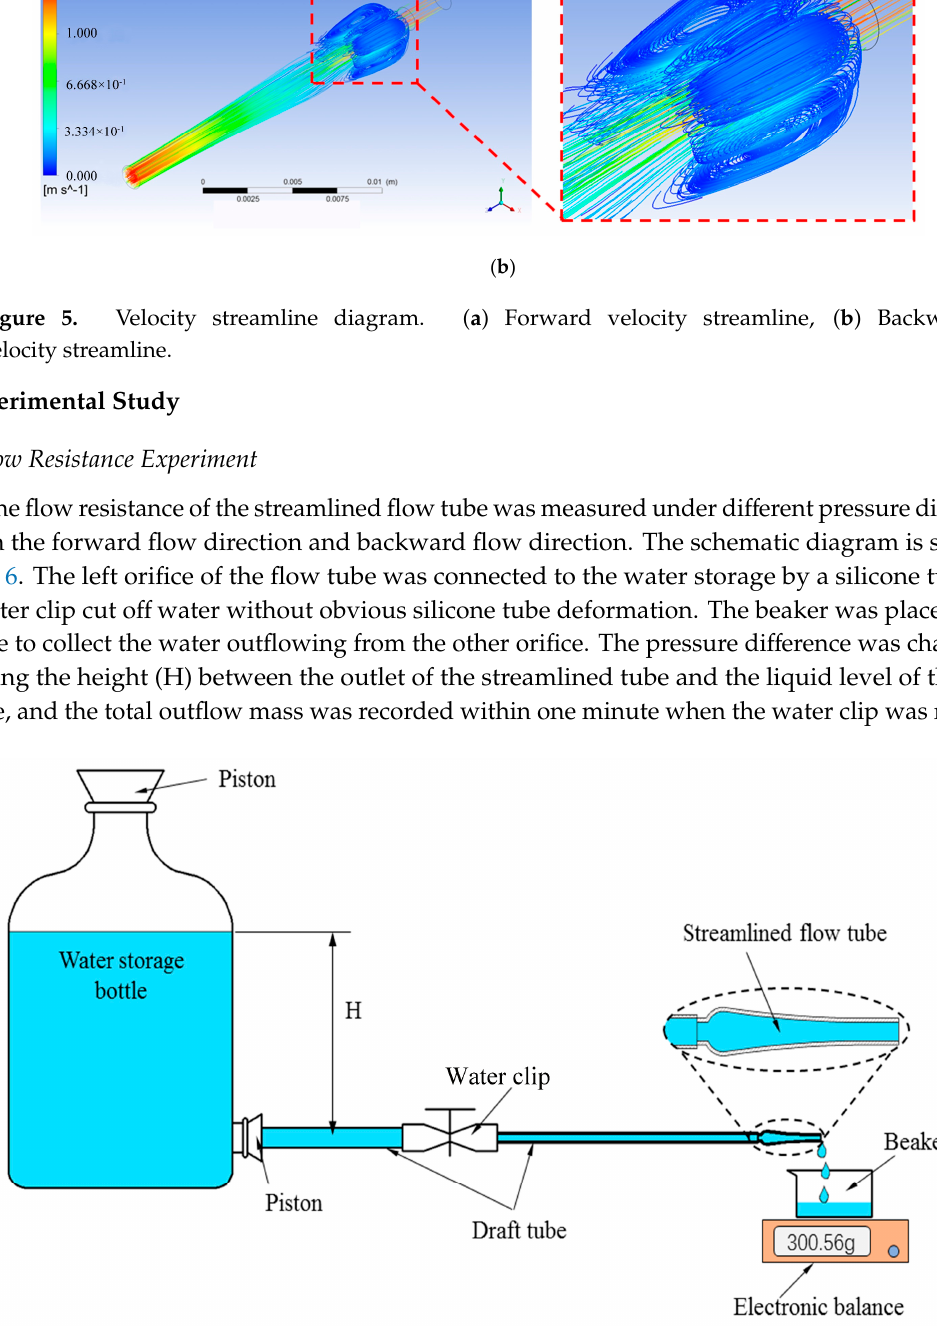
Figure 6. Flow resistance test schematic.